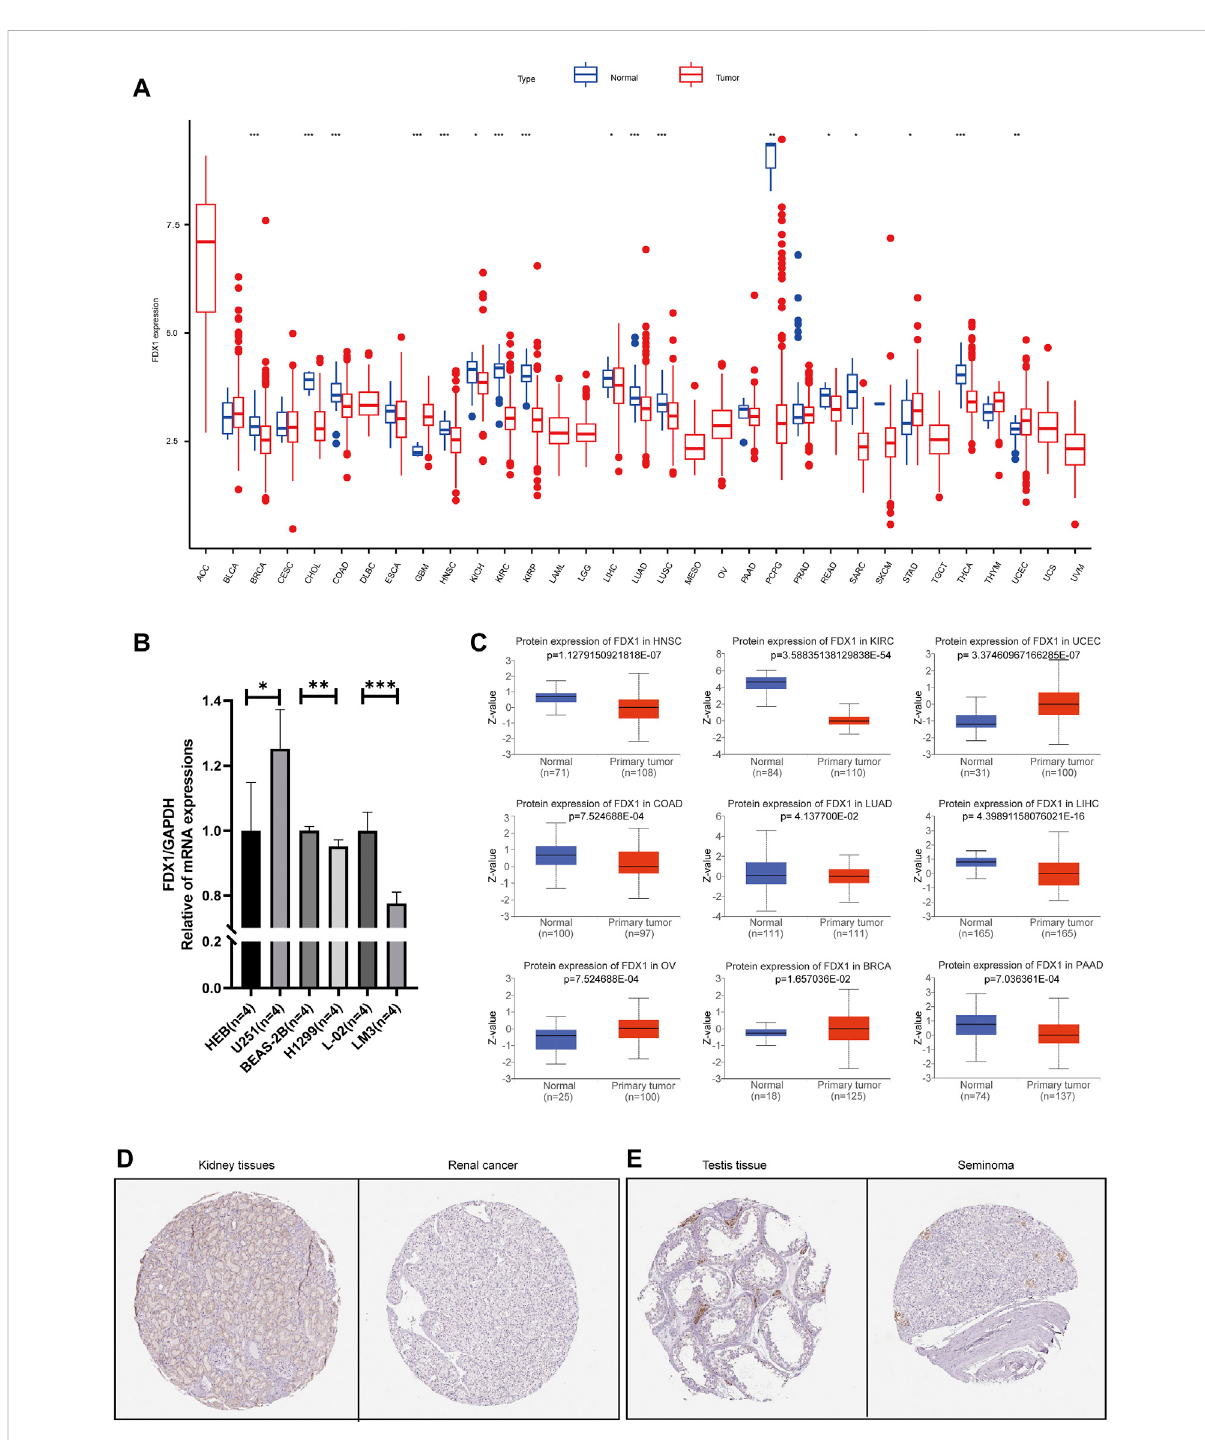
FIGURE 1 Differential expression of FDX1 between normal and tumor tissue samples (A) FDX1 expression in pan-cancers and their corresponding normal samples fromUSCS Xena (B) The mRNAlevel ofFDX1was highly expressedinU251(GBM) cell line compared to HEB cellline (normal).However,the expressionsinBEAS-2BandL-02celllines(normal)werehigherthanthoseinH1299(LUAD)andLM3(HCC)celllines,respectively (C) Thedifferential proteinlevels of FDX1indifferenttumors. Validation ofimmunohistochemical pictureresults attheproteinlevel ofFDX1 (D) Normalkidney and renal cancer (E) Normal testis and seminoma. The red boxplot represents tumor (T) and the blue boxplot represents normal tissue